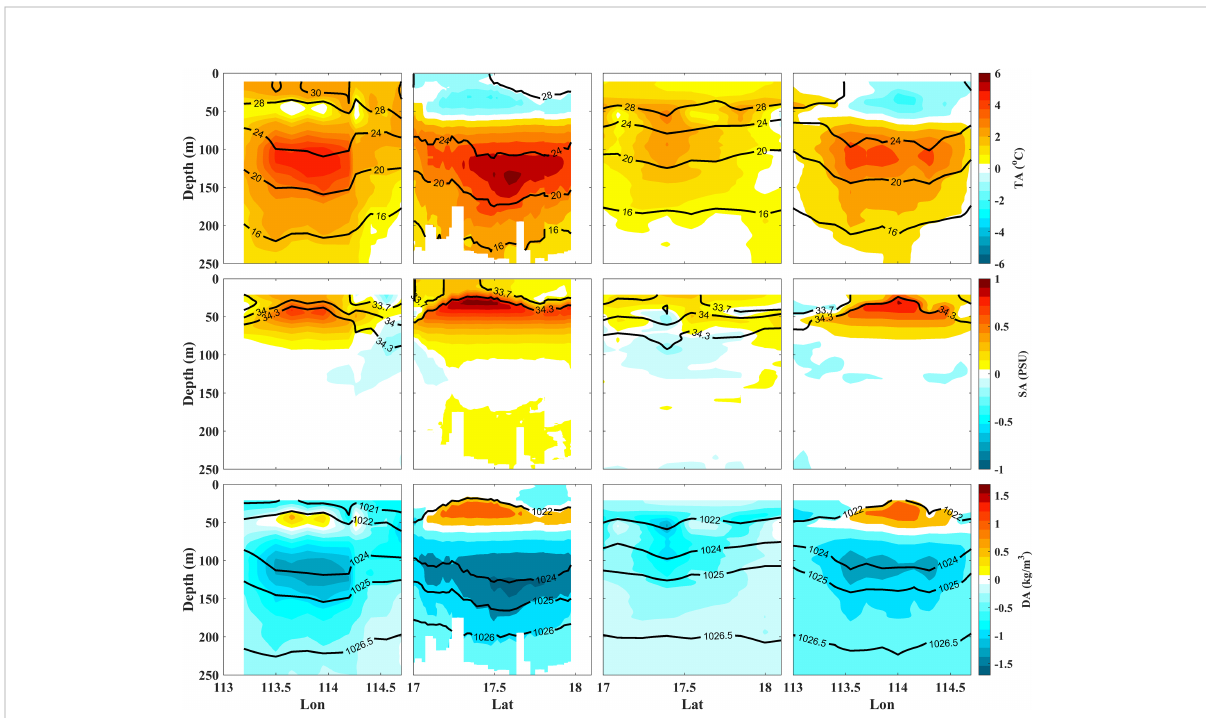
FIGURE 3 The four investigated thermohaline vertical sections of the warm eddy measured by A, B, C and D from left to right, respectively. The T (unit: °C) structures of the investigated vertical sections are shown in upper panels, where the shaded areas show the magnitude of TA (unit: °C), and the solid black lines indicate isotherms. The S (unit: PSU) structures of the investigated vertical sections are shown in middle panels; the shaded areas show the magnitude of SA (unit: PSU), and the solid black lines indicate iso-salinity lines. The Den (unit: kg/m 3 ) structures of the investigated vertical sections are shown in bottom panels; the shaded areas show the magnitude of DA (unit: kg/m 3 ), and the solid black lines indicate isopycnal lines. The x-axis indicates latitudinal and longitudinal ranges. The y-axis indicates the water depth from 0 m to 250